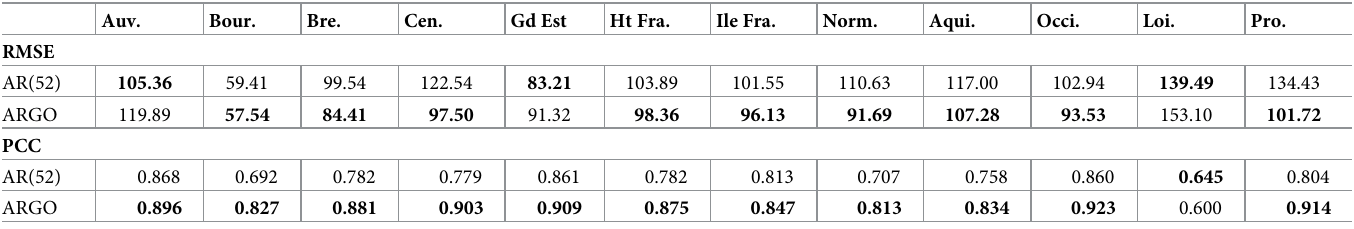
Table 2. One-week ahead estimate—RMSE and PCC for ARGO models including only historical data (AR(52)) and the ten most correlated variables from hospital and Google data, for the period starting from January 2015 to March 2017. Auv. Bour. Bre.